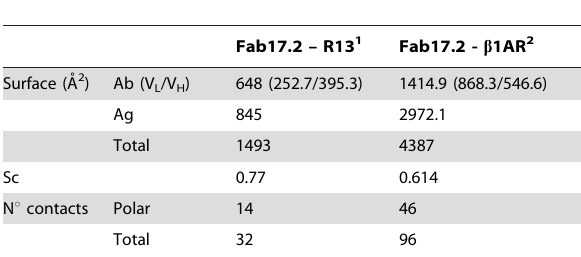
Table 4. Buried surface upon complex formation, with shape complementarities (Sc) [50] and number of contacts observed between the mAb 17.2 and the R13 peptide in the crystal structure 1 and the model 2